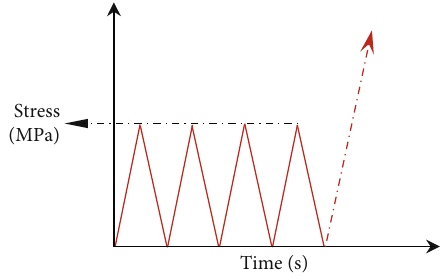
Figure 4: Cyclic loading mode. The compressive strength of rock sample is 40% and the loading/unloading slope is k = ±0 : 1 MPa/s.